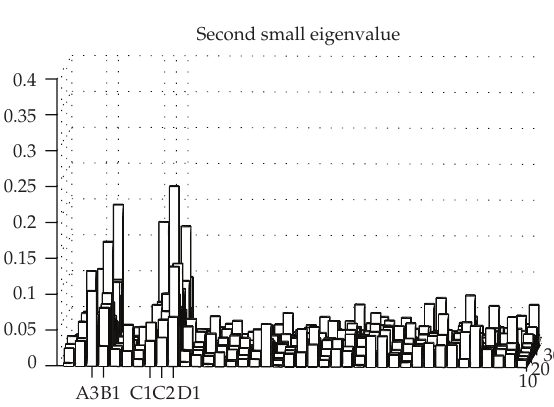
Figure 8: The spectrum of the second small eigenvalue with observation points A3, B1, C1, C2, D1.